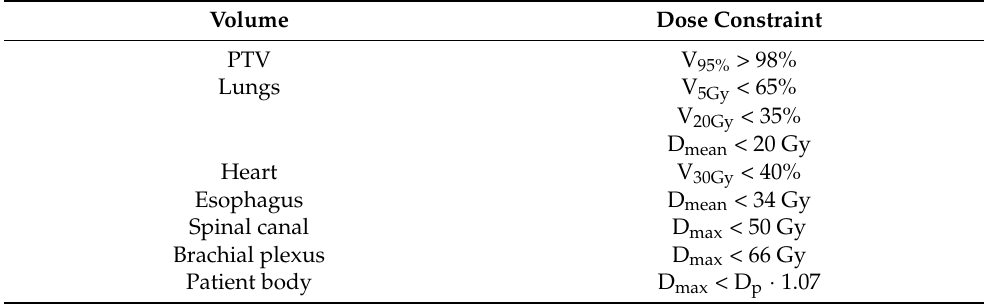
Table 1. Planning dose constraints for the PTV, OARs and normal tissue. D p = prescribed dose. In cases where fulfilling all constraints was impossible, the responsible oncologist decided whether target coverage or OAR constraints should be